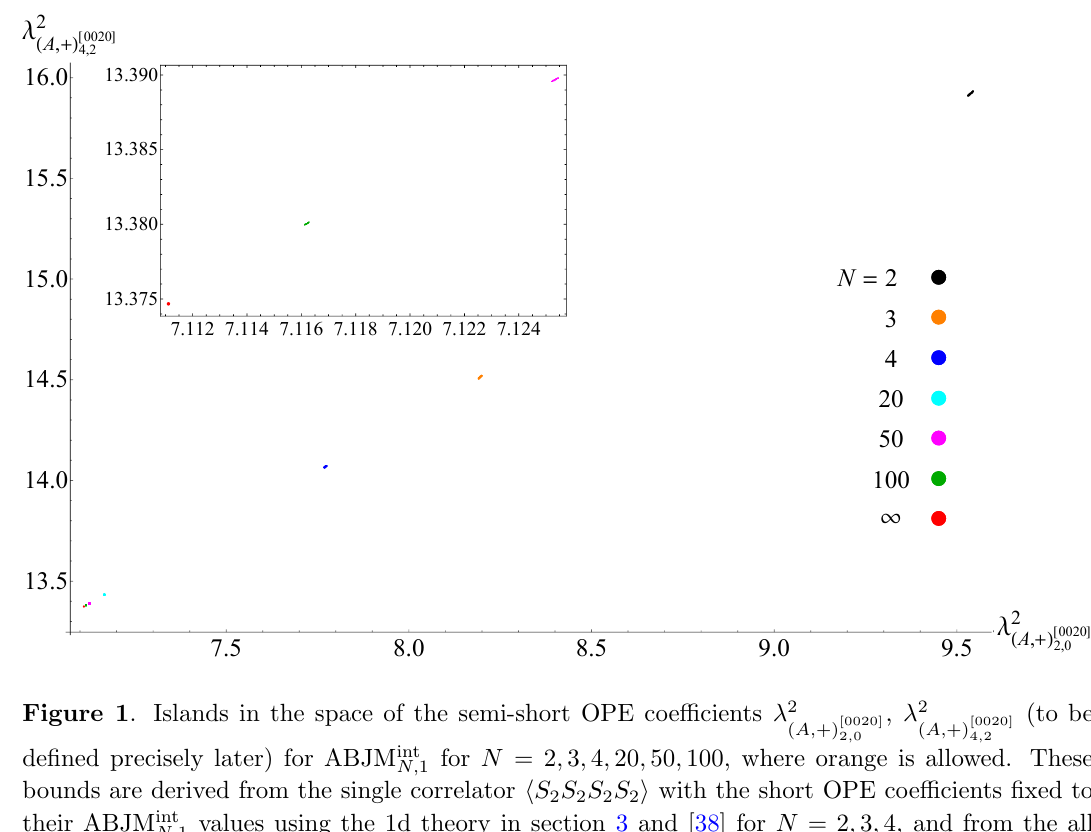
for N = 2 ; 3 ; 4 ; 20 ; 50 ; 100, where orange is allowed. N; 1